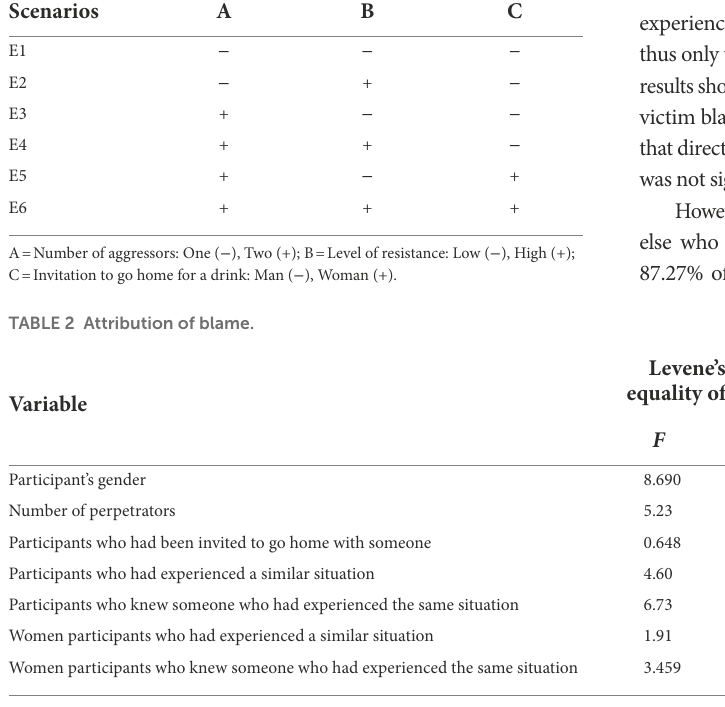
TABLE 1 Different scenarios with variables.